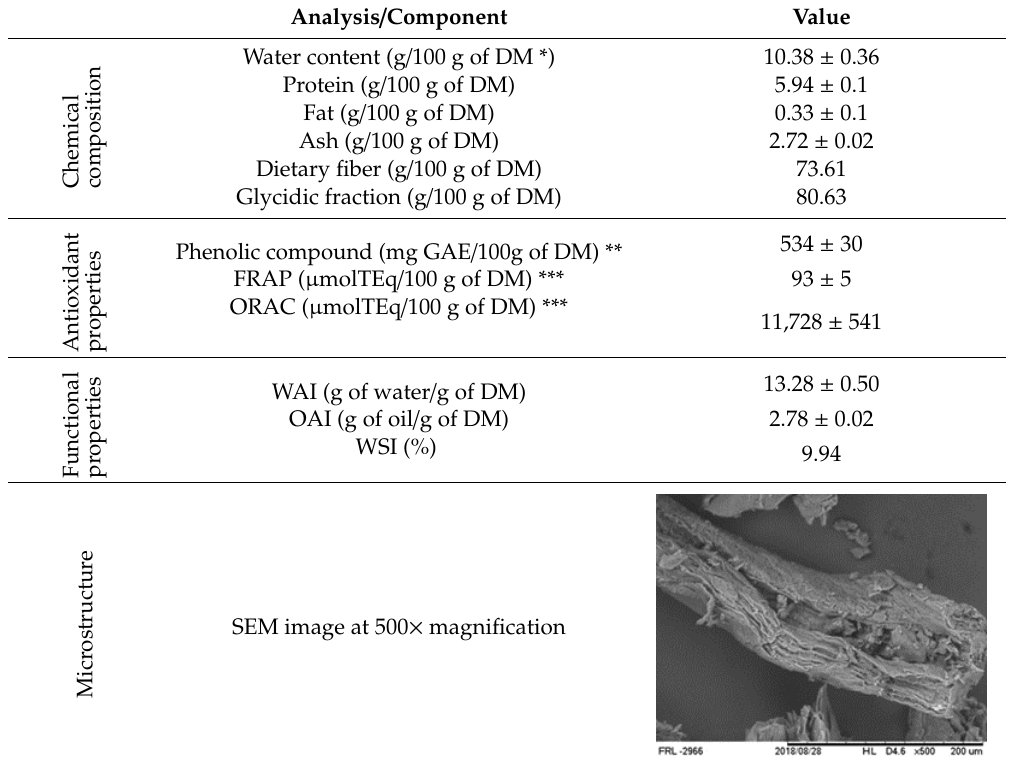
Table 2. Results from the different analysis of the orange by ‐ product flour